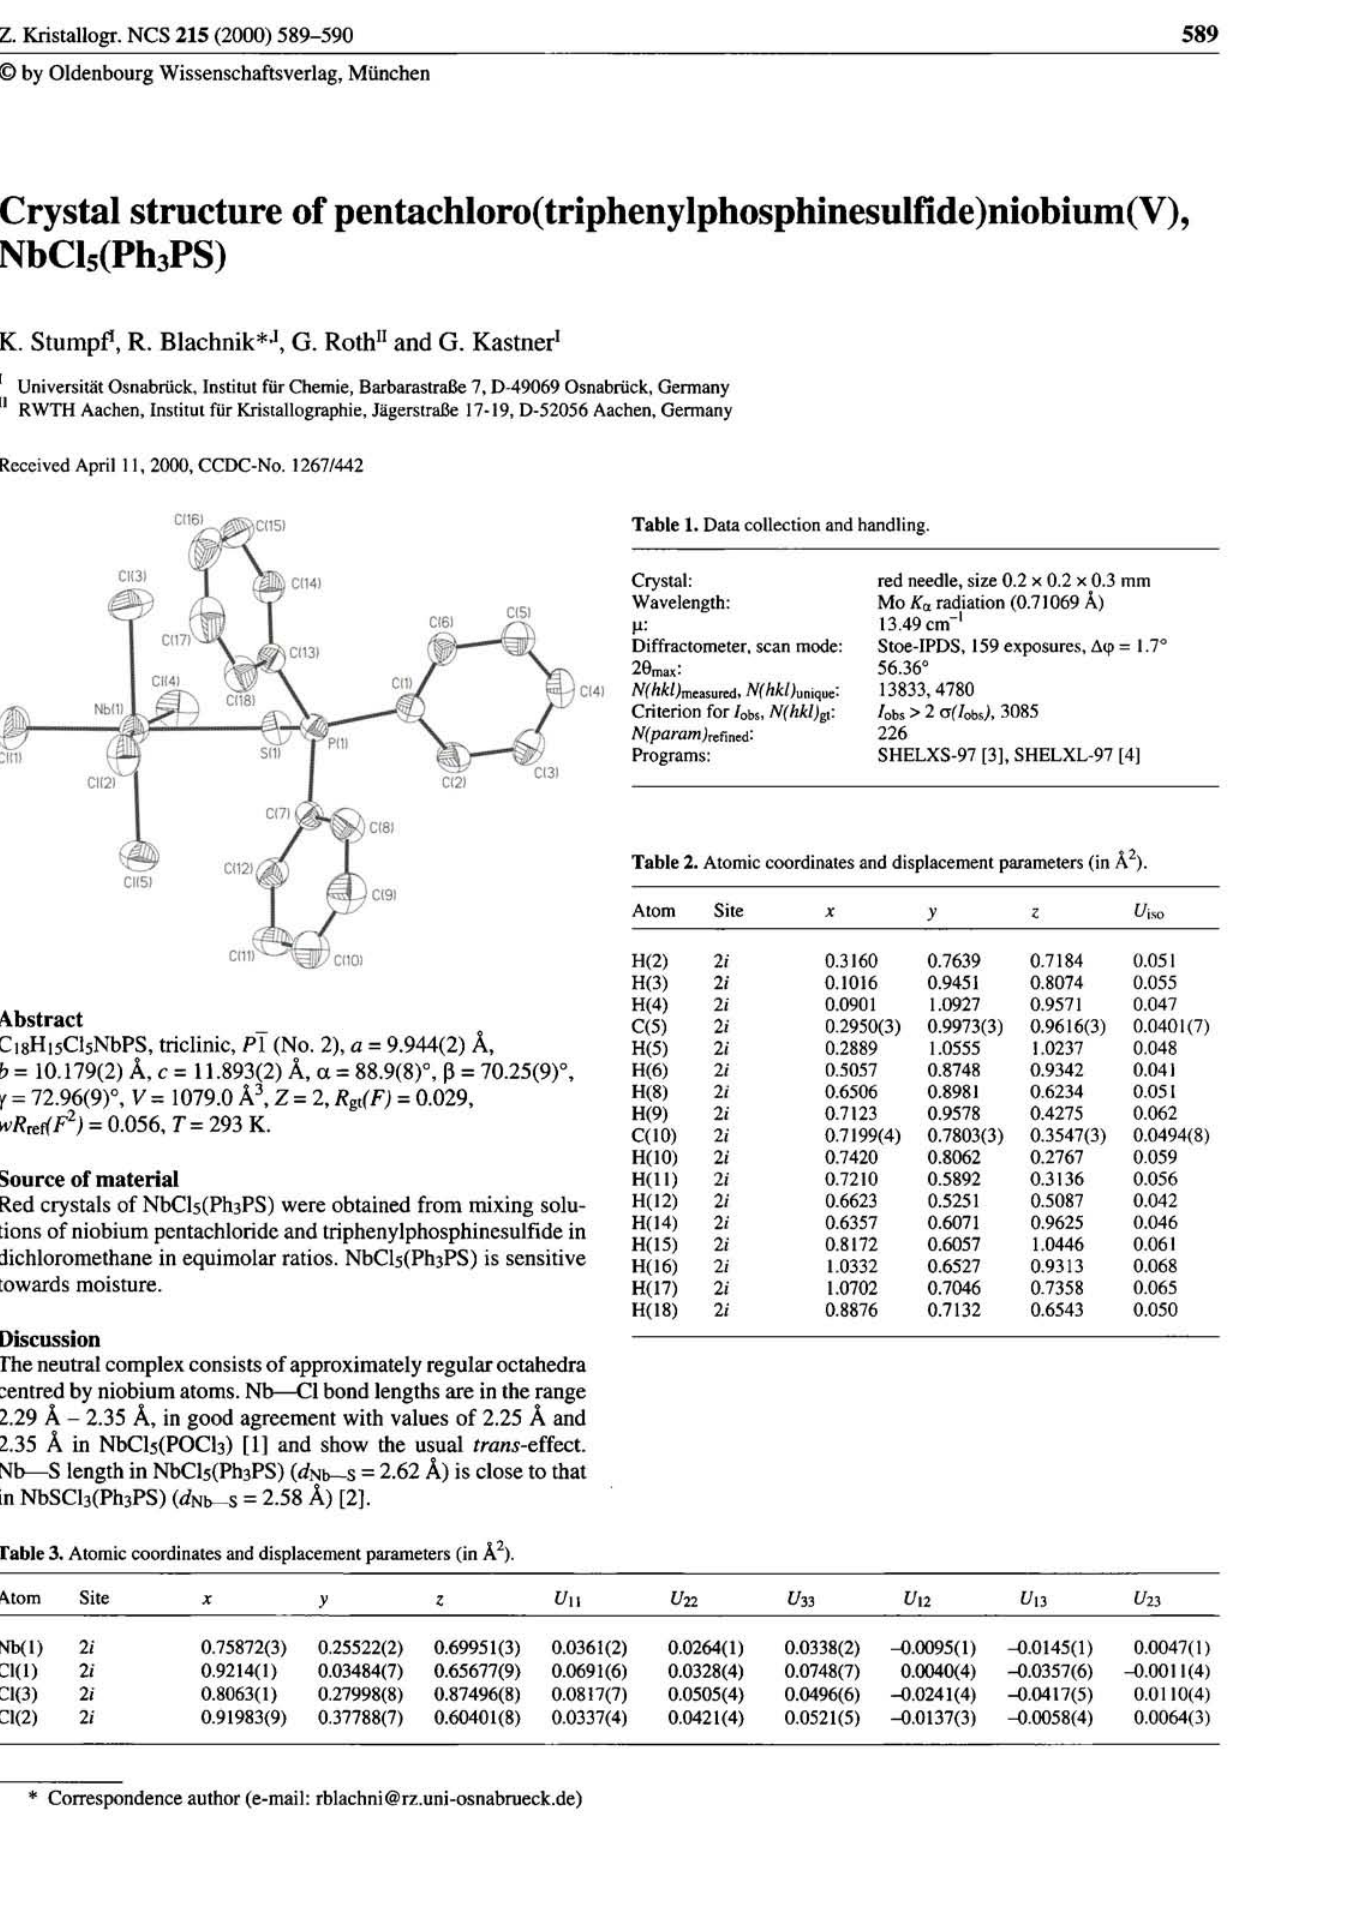
Table 3. Atomic coordinates and displacement parameters (in A 2 ).